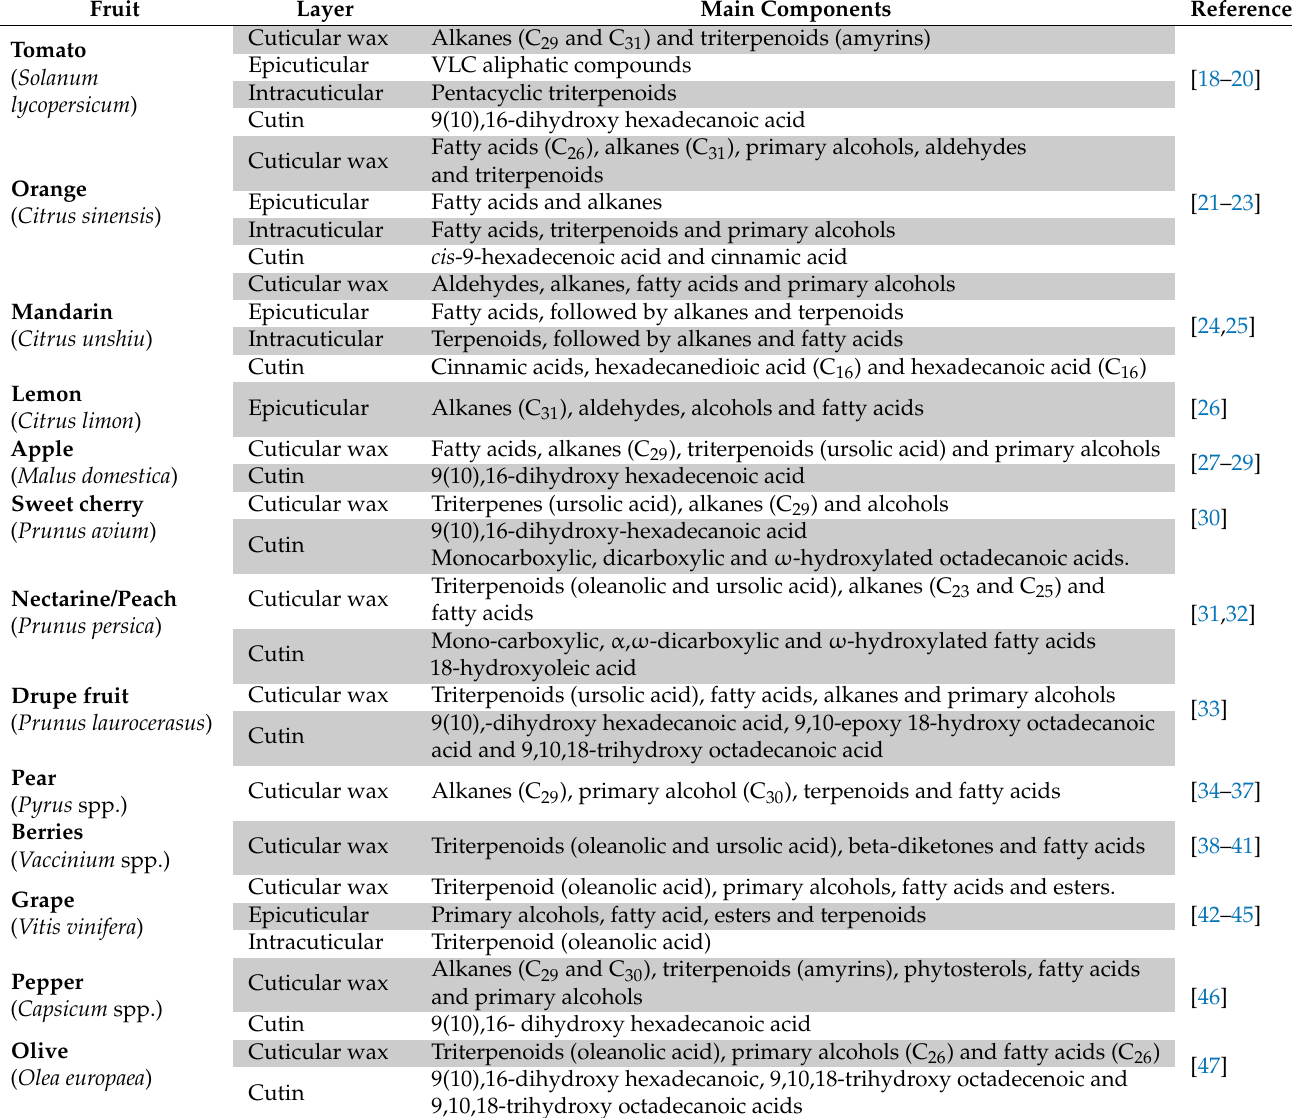
Table 1. The main cuticle components present in fleshy fruits of different species. Main